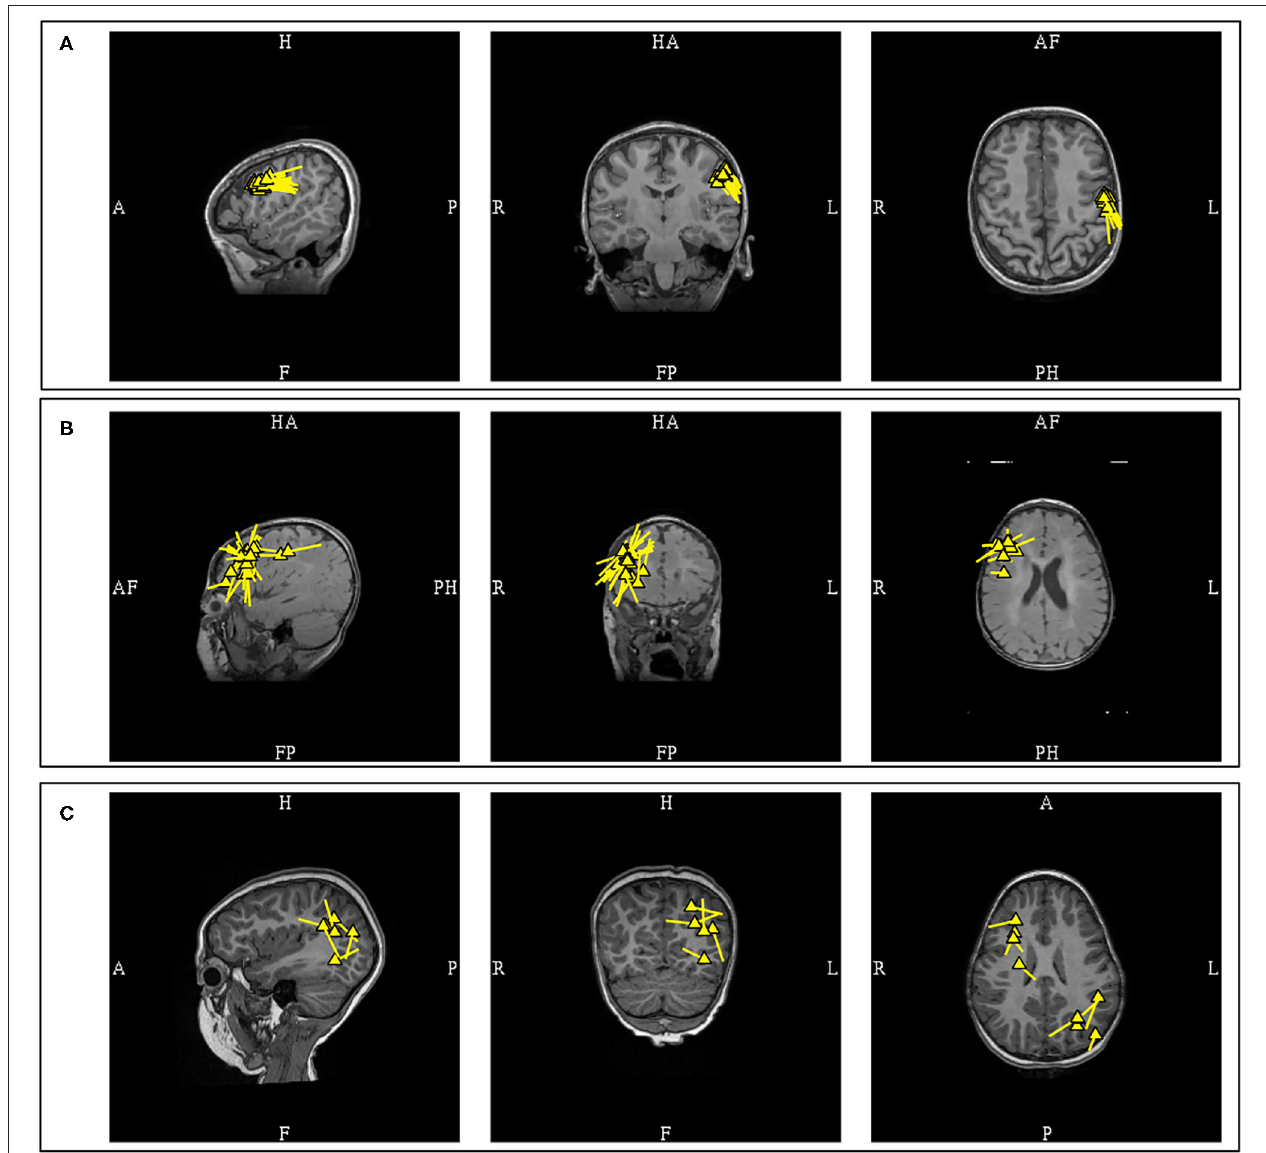
FIGURE 6 | MEG-MRI coregistration summary demonstrating varied cluster patterns. (A) Monofocal tight cluster with uniform vector orientation localized to the left pre-central region, with dipoles posteriorly oriented. (B) Monofocal loose cluster with variable vector orientation localized to the right dorsolateral frontal region, with additional posterior scattered dipoles. (C) Multifocal and scattered dipoles over the right fontal and left parieto-occipital